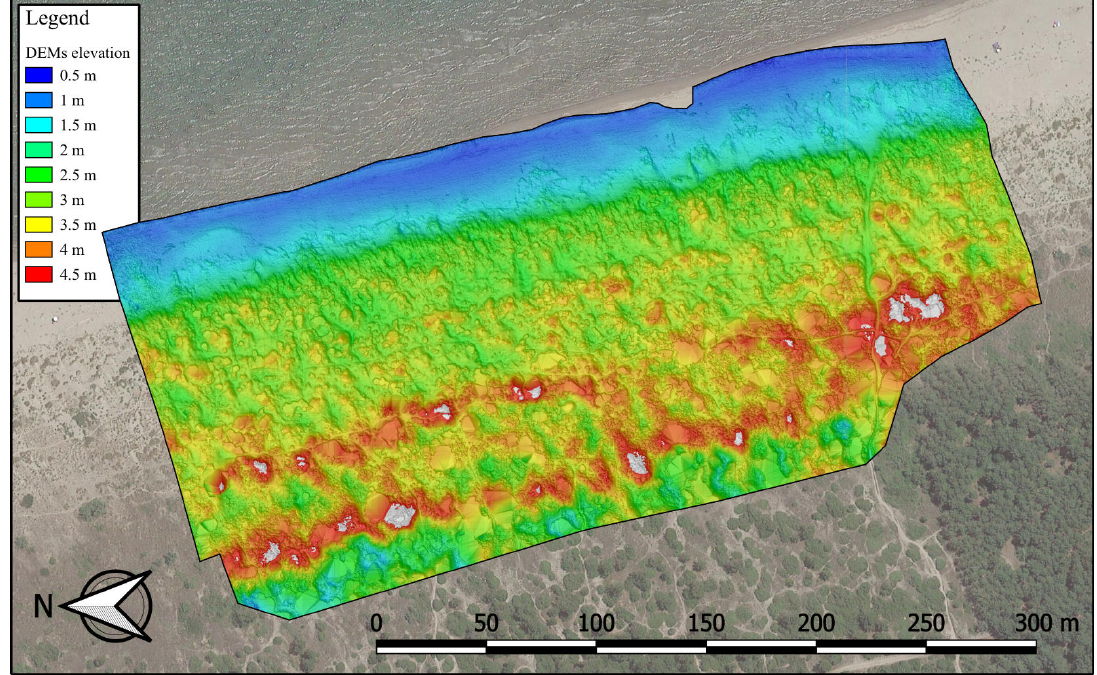
Figure 11. Digital Elevation Model (DEM) of the survey carried out on November